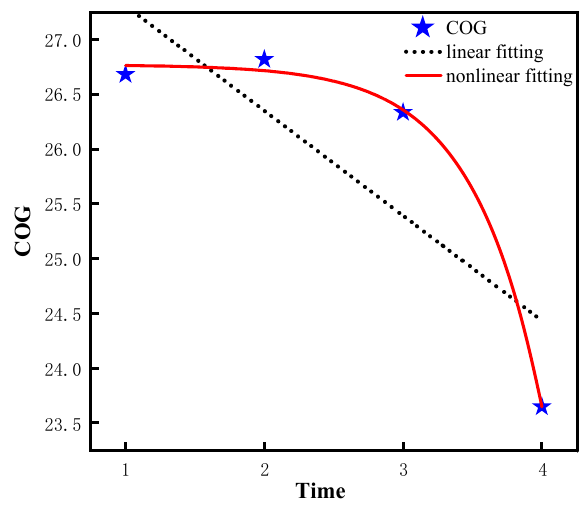
Figure 5. Trajectory of IADL ability of older adults.